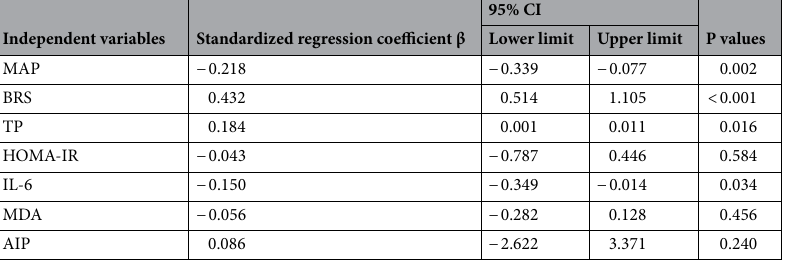
Table 7. Multiple regression analysis of nitric oxide (as dependent variable) with various parameters (as independent variables) in control group at 36th week of gestation. C.I. confidence interval, MAP mean arterial blood pressure, BRS baroreflex sensitivity, TP total power of HRV, HOMA-IR homeostatic model assessment- Insulin resistance, IL-6 interleukin-6, MDA malondialdehyde, AIP atherogenic index of plasma.